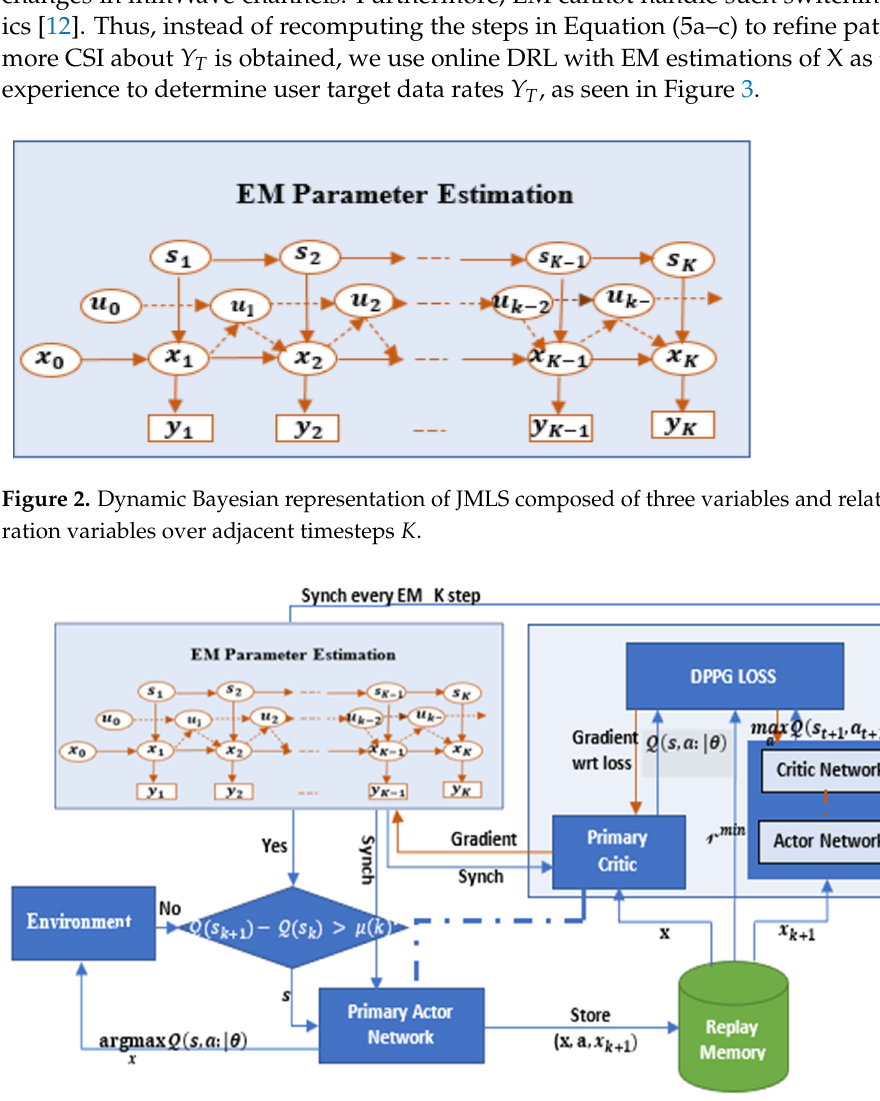
Figure 3. Deep deterministic policy gradient (DDPG) algorithm structure.